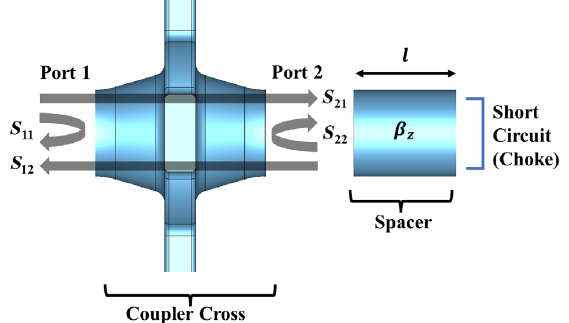
mode.FIG. 6. Transmission of the TE 11 mode through the TM 01